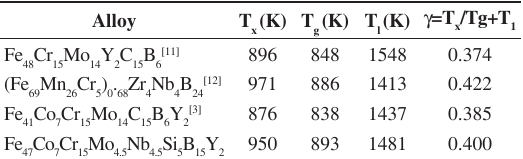
Figure 2. DSC Thermograms of Fe amorphous sample obtained at heating rates of 40 Table 3. The glass transition temperature, T temperatures, T different glass metallic alloys.